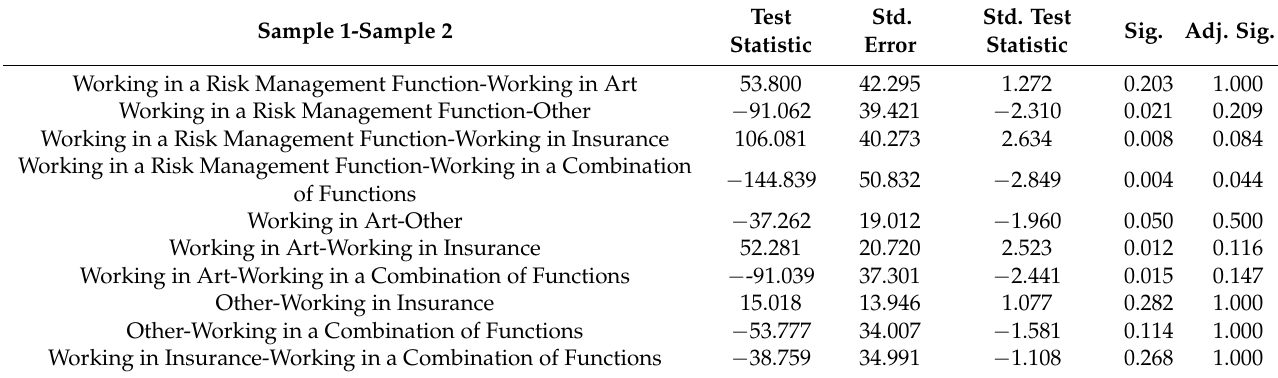
Table 17. Post hoc analysis—changes in the interpretation of art value.